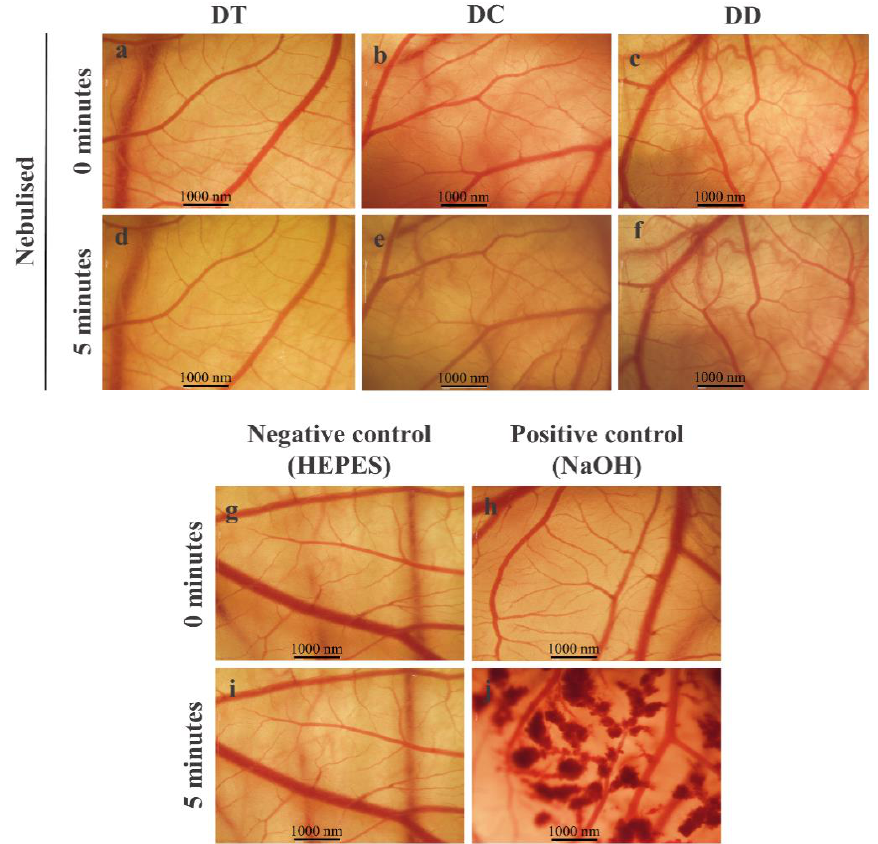
Figure 5. HET-CAM assay for mucous membrane compatibility of nebulised curcumin-loaded liposomes ( a – f ). HEPES 20 mM pH 7.4 served as negative control ( g , i ); 0.1 N NaOH as positive control ( h , j ) . Scale bars represent 1000 nm.